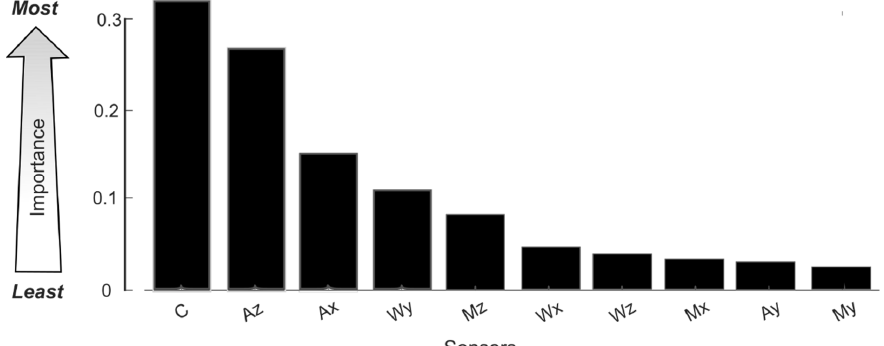
Figure 8. Information gained (IG) is the percentage of total information the model gained by a feature in classifying use events. Using the average IG of all features with respect to the sensor, the importance of a sensor in classifying a use event can be determined. Sensors ranked were the accelerometer (A), magnetometer (M), gyroscope (W), and capacitance sensor (C). Data from sensors related to the orientation of the bottle and the capacitance were the most important. Reed switches were not included in importance rankings because the built in algorithm only runs when the reed switches indicate the cap has been removed.